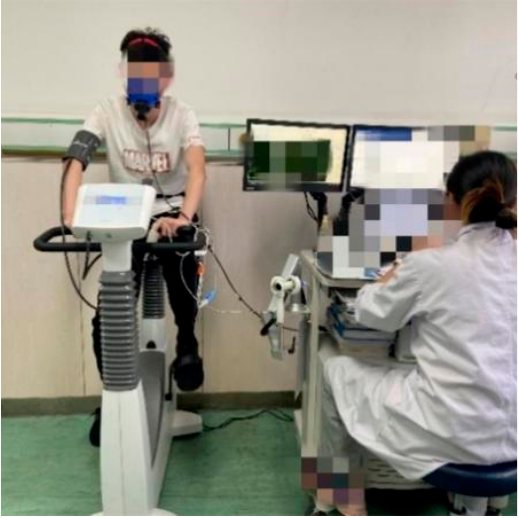
Figure 1. Illustration of cardiopulmonary exercise testing.